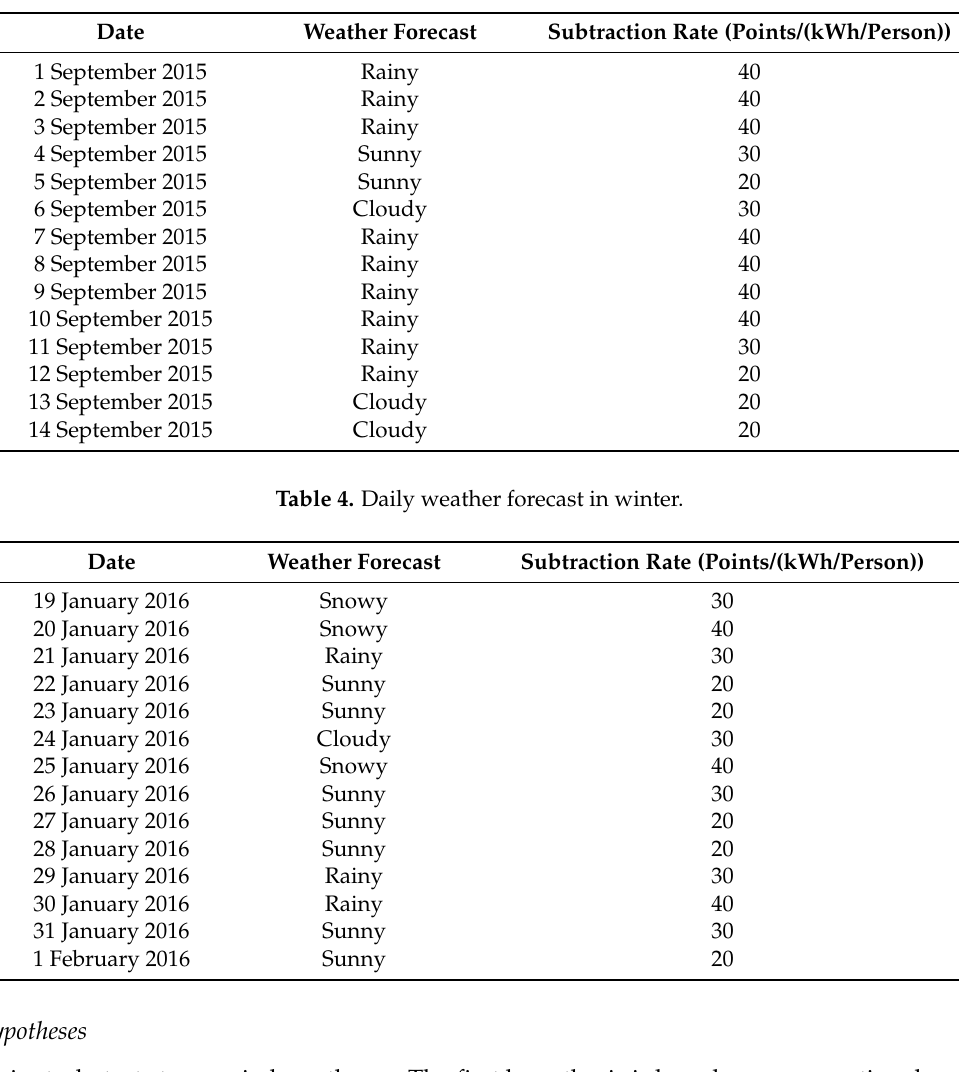
Table 3. Daily weather forecast in summer.